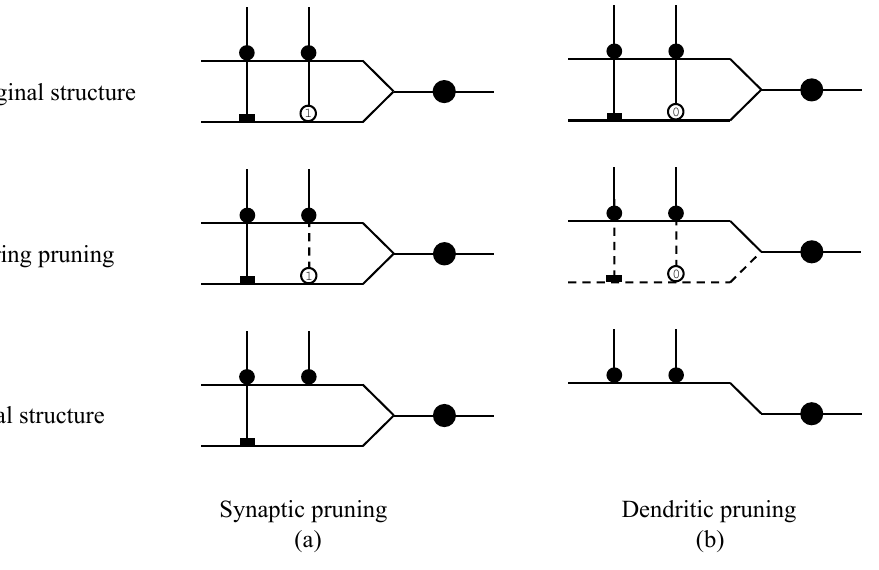
Figure 4. Synaptic pruning and dendritic pruning on two trained